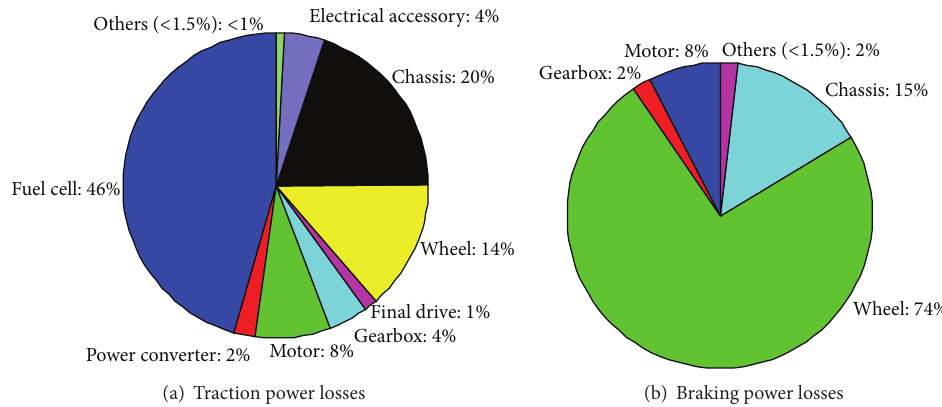
Figure 11: Vehicle traction/braking power